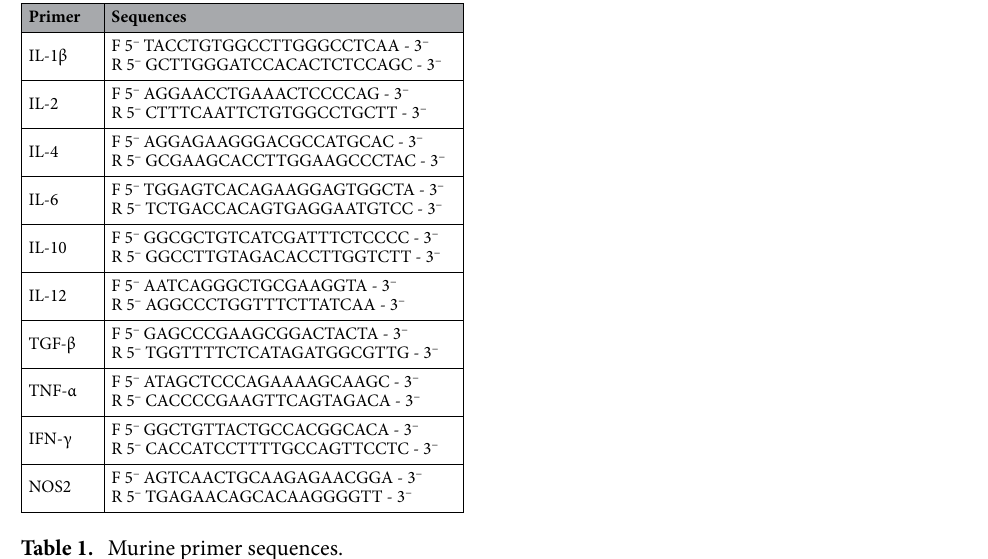
Table 1. Murine primer